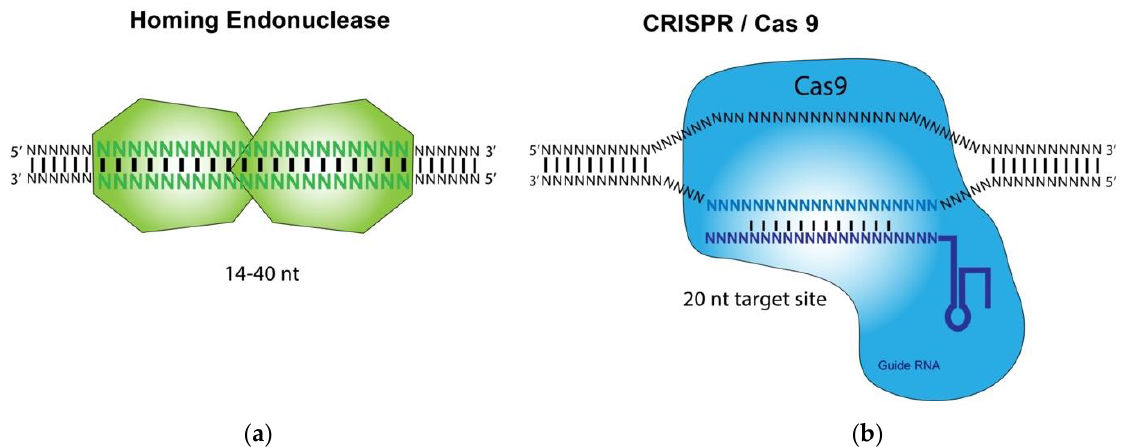
Figure 1. Illustration of the homing endonuclease (HE, meganuclease) and CRISPR/Cas9 System: ( a ) Homing endonuclease-mediated recognition and binding of a DNA substrate leads to the cleavage of the substrate.; ( b ) A custom-designed guide RNA (gRNA) hybridizes its target sequence and directs Cas9 endonuclease to cleave a DNA substrate.